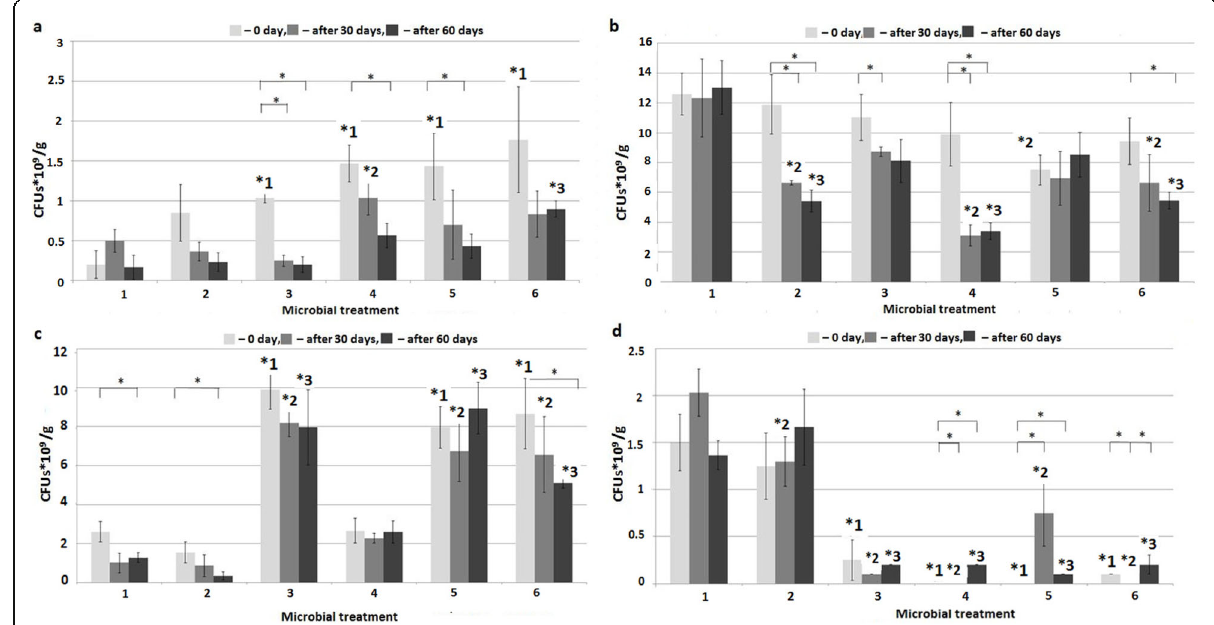
Fig. 1 Number of CFUs of fungi ( a ), bacteria ( b ), B. subtilis ( c ) and Actinobacteria ( d ) in control and in soil samples treated with different microorganisms and their consortia over different time periods. * — significant ( P < 0.05) difference between samples at the same treatments at different times; * 123 — significant difference from control at the same time; standard deviation is obtained from three